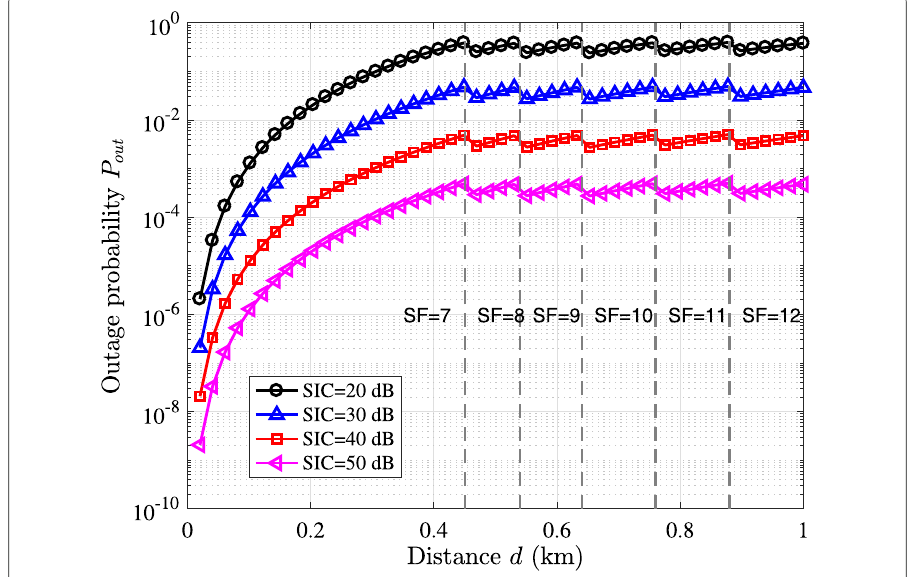
lower than that in sub-urban scenario ( α = 2.7). The reason is that the communication range in the urban is much shorter, which results in higher received power thus higher S INR before SIC.